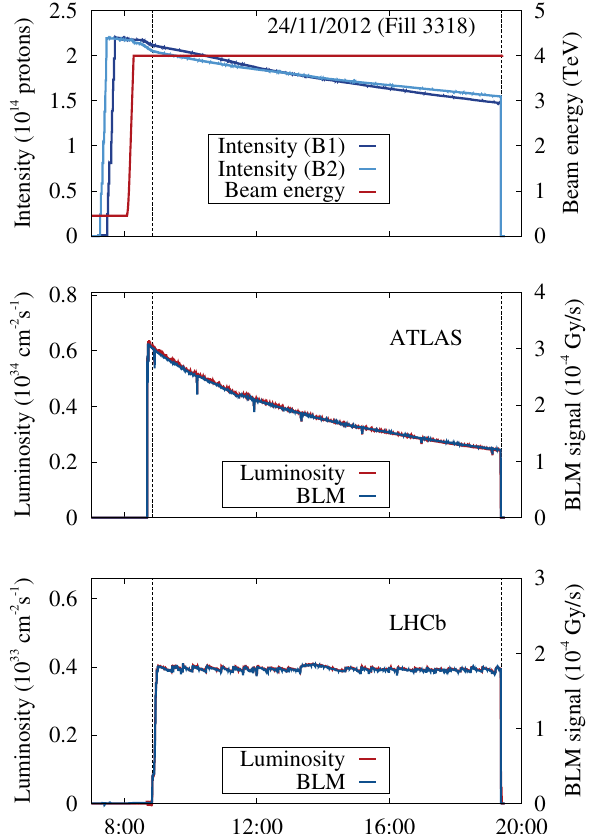
FIG. 14. Time evolution of beam intensities during a regular proton physics fill in 2012 (top) together with the instanta- neous luminosity delivered to ATLAS (center) and LHCb (bottom), as well as the dose rates measured by a BLM about 23 m from the respective interaction point. The vertical lines indicate the time period where the LHC was in stable collision beam mode. The center-of-mass energy of the two colliding ffiffiffi p s ¼ 8 beams was